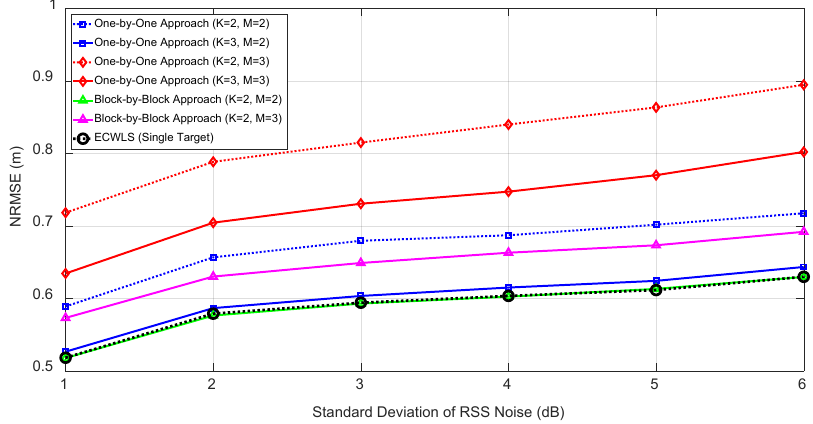
Figure 9. NRMSE according to the number of targets ( M ) and RSS noise ( σ w